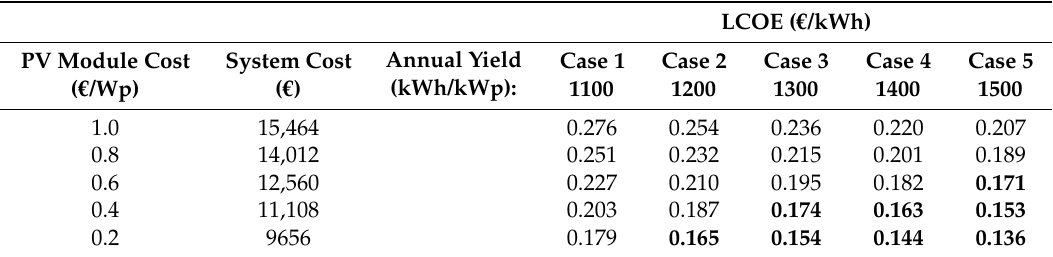
Table 6. Comparison of the LCOE based on the different annual yield for 5 kW (deterministic method).